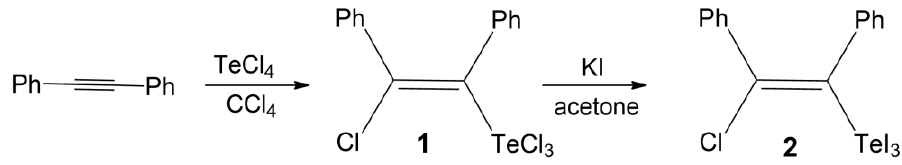
Figure 2. Preparation of Cl(Ph)C=C(Ph)TeCl 3 ( 1 ), and Cl(Ph)C=C(Ph)TeI 3 ( 2 ).